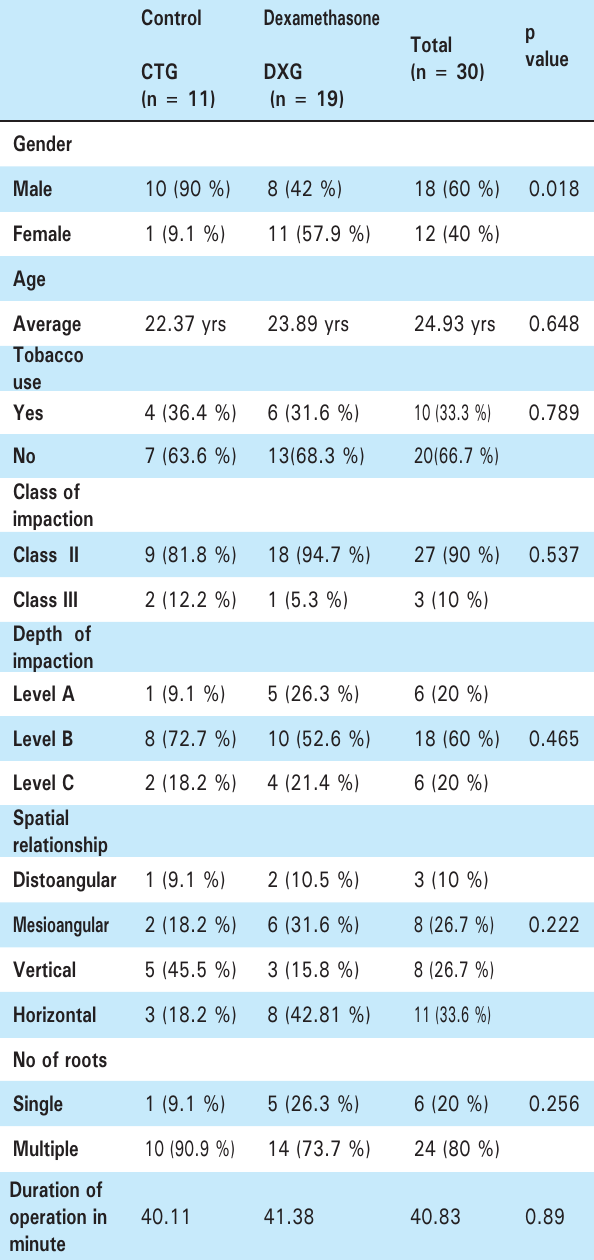
Table1. Descriptive statistics for the demographic and